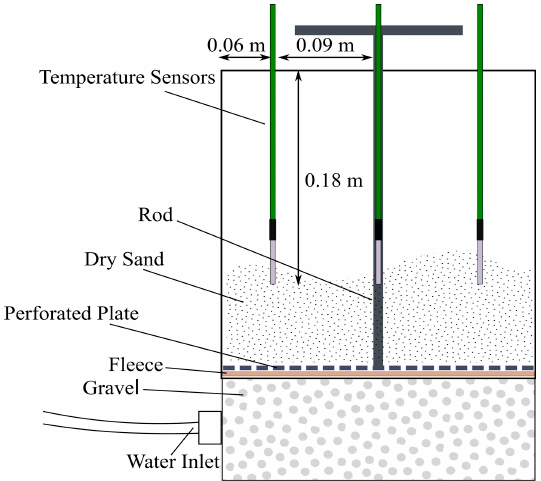
Figure 5. Installation box (screw system) for the modelling of the frozen sand sample depicting permafrost at lowest model generation. When removing the box for installing the specimen in the flume for further testing, the bottom part (gravel and fleece) was also removed, while the perforated plate and threaded rod remained inside the specimen.